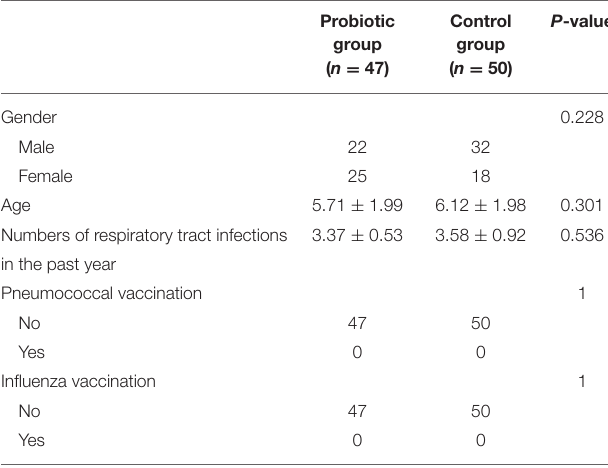
TABLE 1 | The baseline characteristics of children with recurrent respiratory tract infections (RRTi).